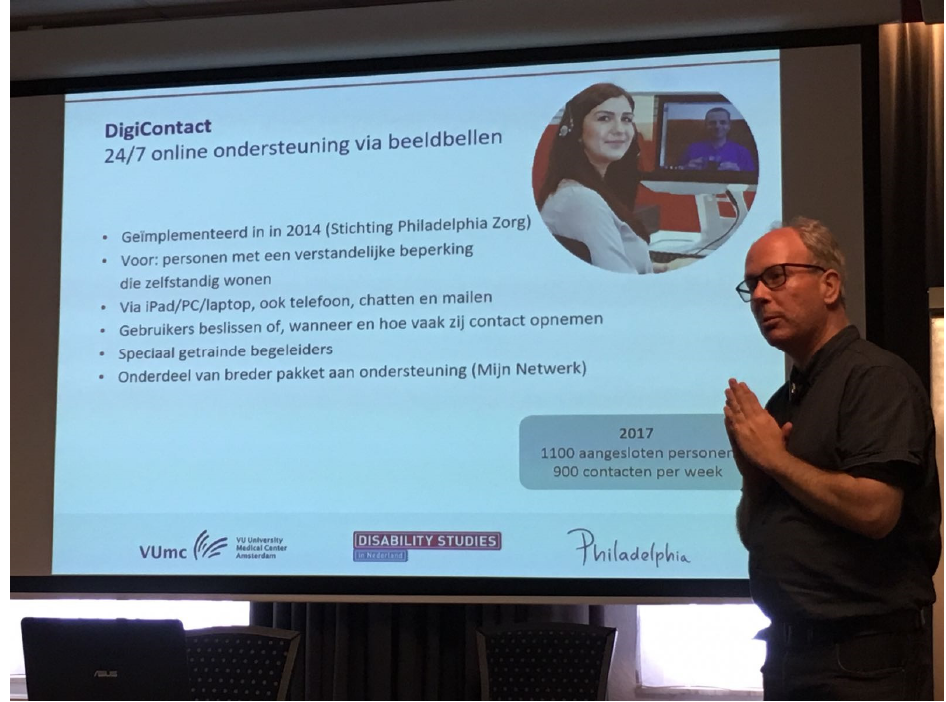
Figure 2. Mark presenting (21 June